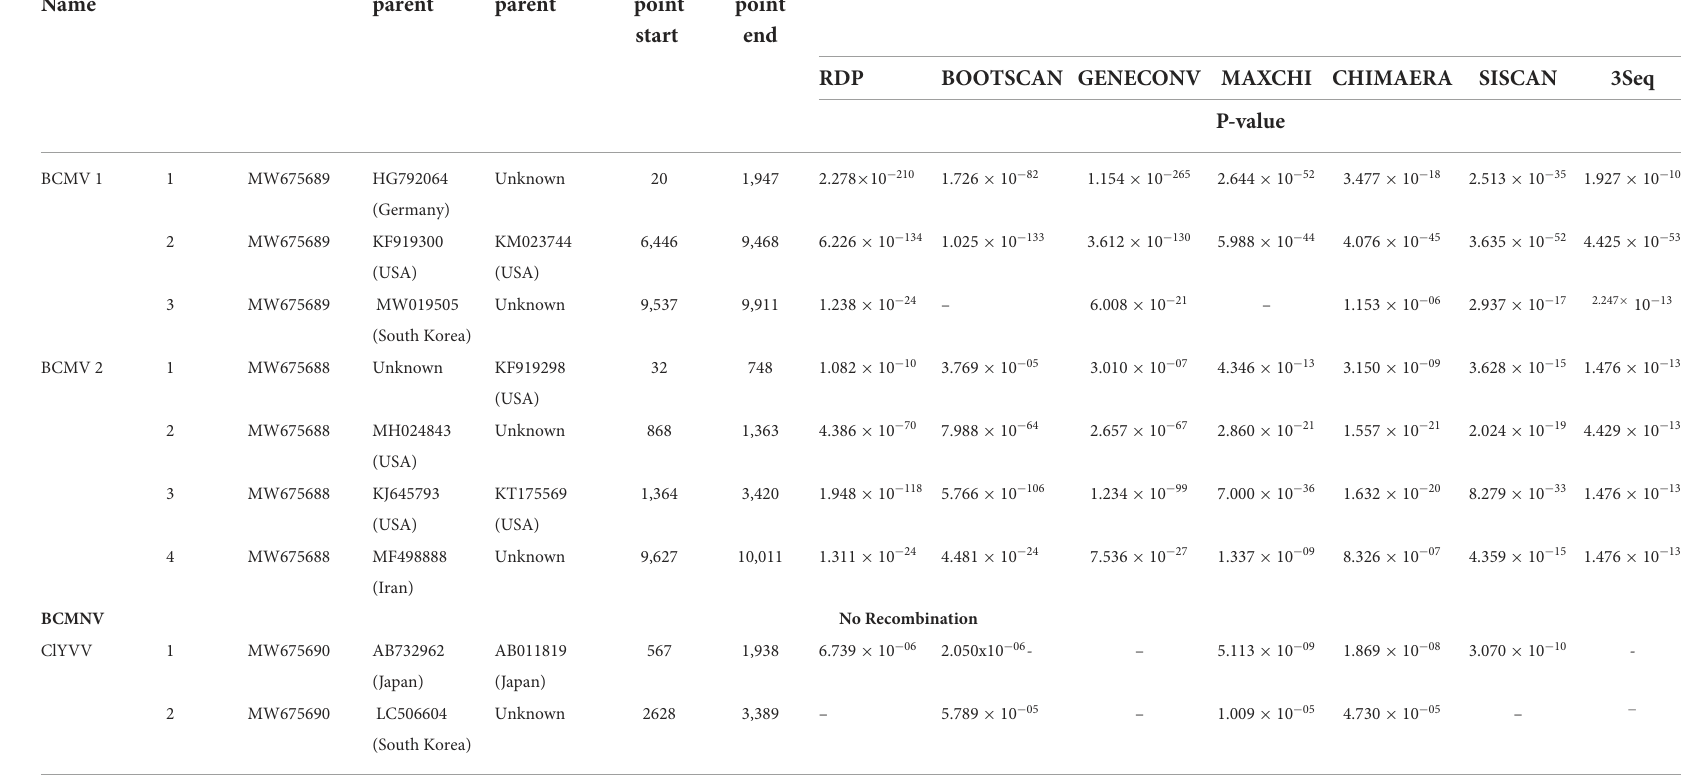
TABLE 5 The recombination events detected along with major and minor parents, p-value of viruses detected in common